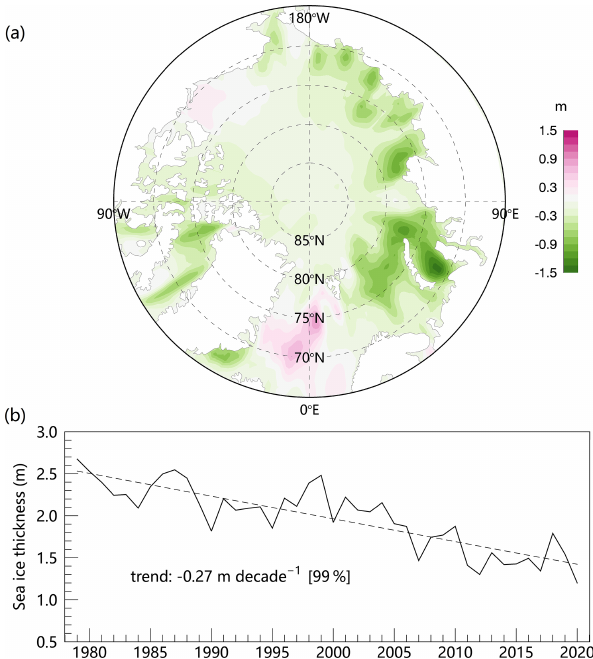
Figure 7. (a) Changes in SIT caused by anomalies of surface radia- tive fluxes during spring (April to June) 2020 which is estimated by a simplified sea ice growth model. (b) Time series of SIT (provided by PIOMAS) and the corresponding trend (dashed line) averaged over the study area in spring during the period